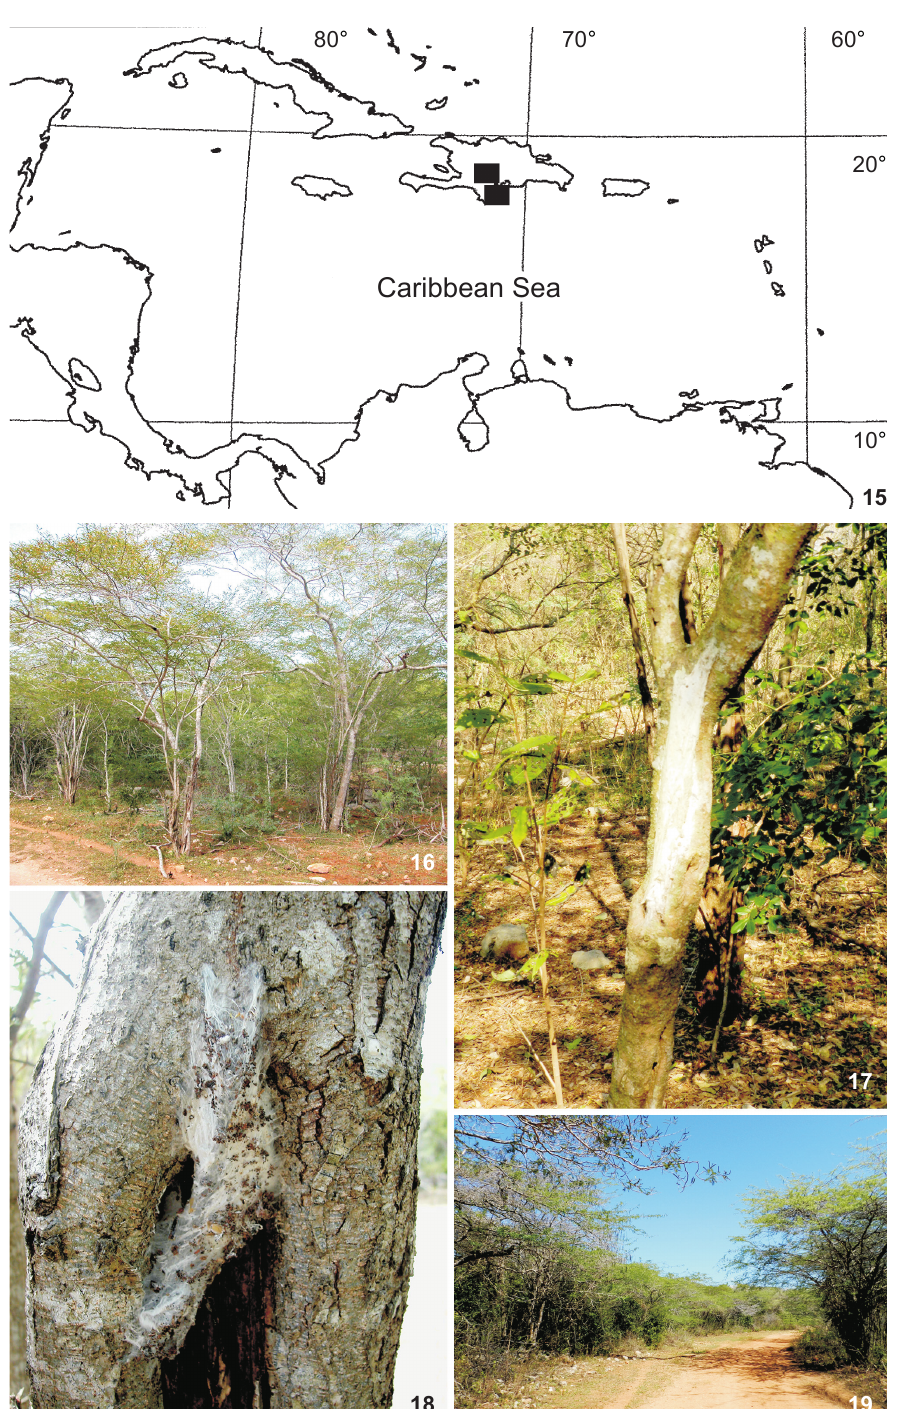
Figures 15-19. Avicularia rickwesti sp. nov. : (15) records in Dominican Republic; (16-19) habitats in Dominican Republic: (16, 19) dry deciduous forest in Baoruco, s. Manuel Golla; (17) retreat, female; (18) retreat, Baoruco, s. Manuel Golla. Photos: 16, 18, Jeremy Huff; 17, 19, Rick